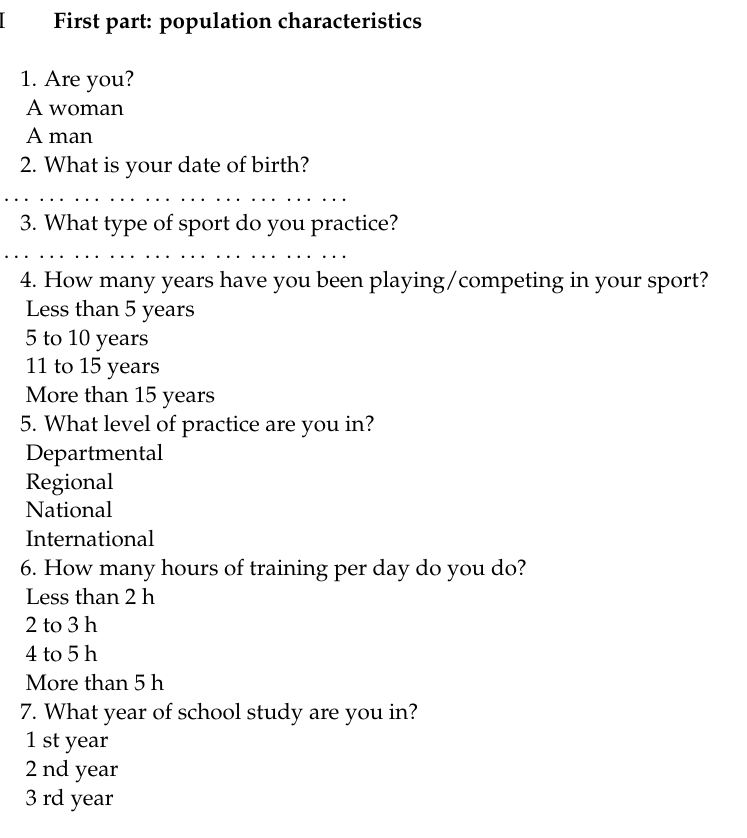
Table S2: Other sleep disrupters based on sport’s category. Table S3: Other sleep disrupters based on level of practice. Table S4: Univariate analyses of sleep disrupters between three different groups according to